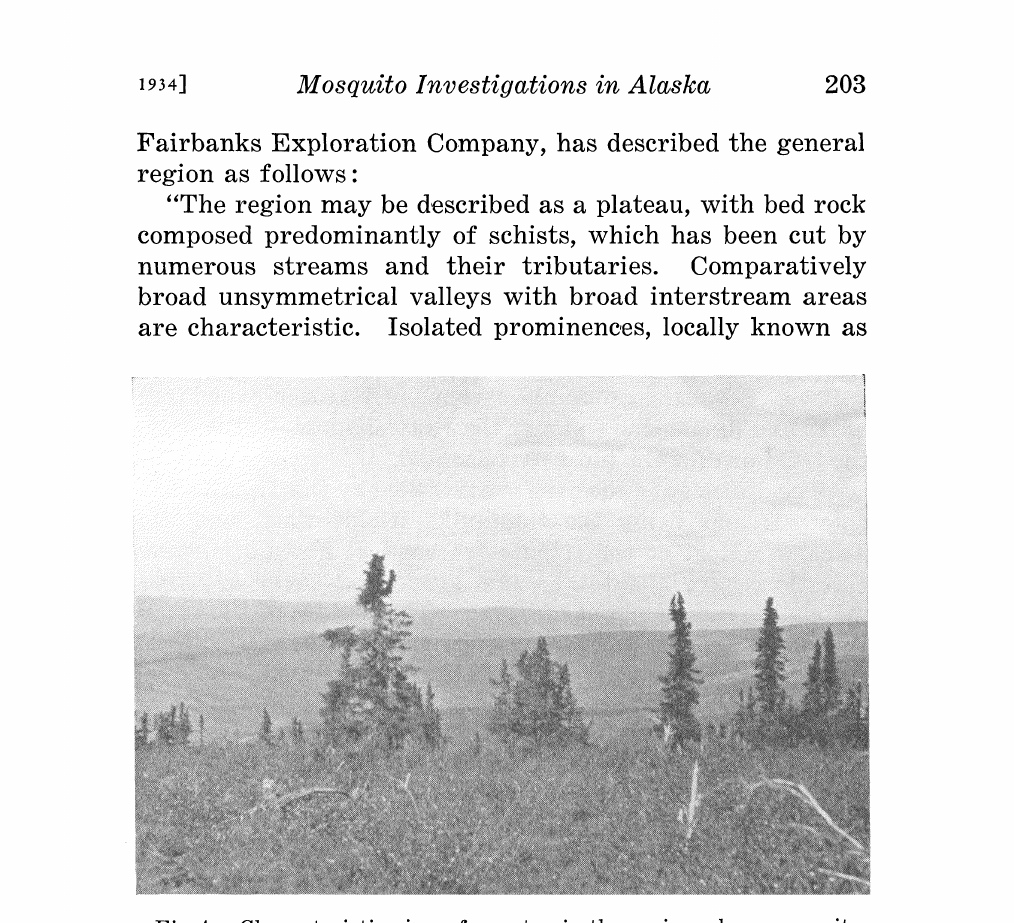
Fig 4. Characteristic view of country in the region where mosquito investiga.tions were